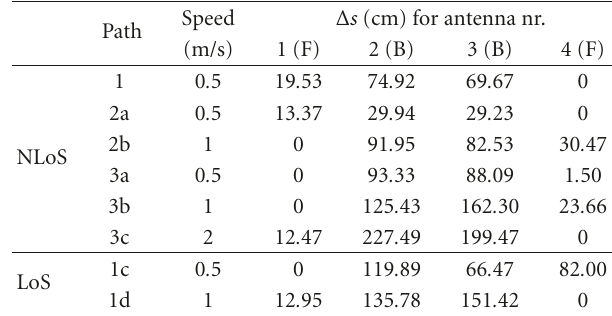
3. Back right antenna 4. Front right antenna Figure 6: Unwrapped phase φ n r of signals received at 45m distance (path 1, NLoS, 0 . 5m/s). Due to the frequency o ff set between transmitter and receiver, an unknown constant phase variation is added, for the synchronous hardware used this added constant is equal for all channels. Table 1: Relative changes in path length for the di ff erent receiving antennas during the 1 second burst. Larger values correspond to a higher increase in signal path